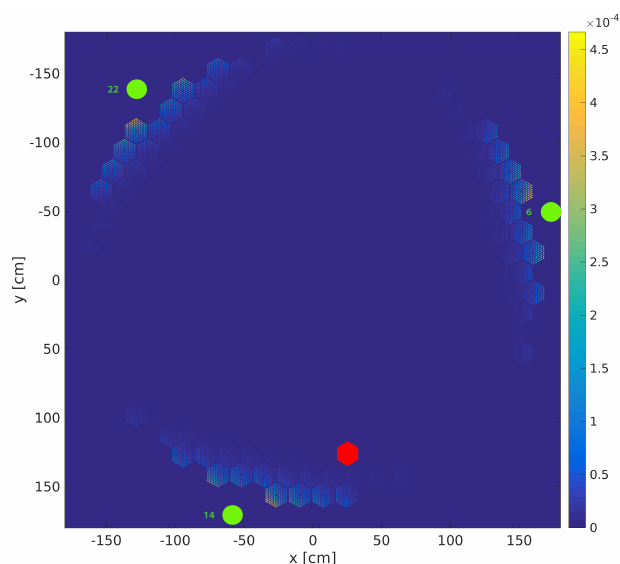
Figure 6. Detector sensitivities in count/fission for all three detectors, detector positions (green circles) and the position of the stuck safety assembly (red